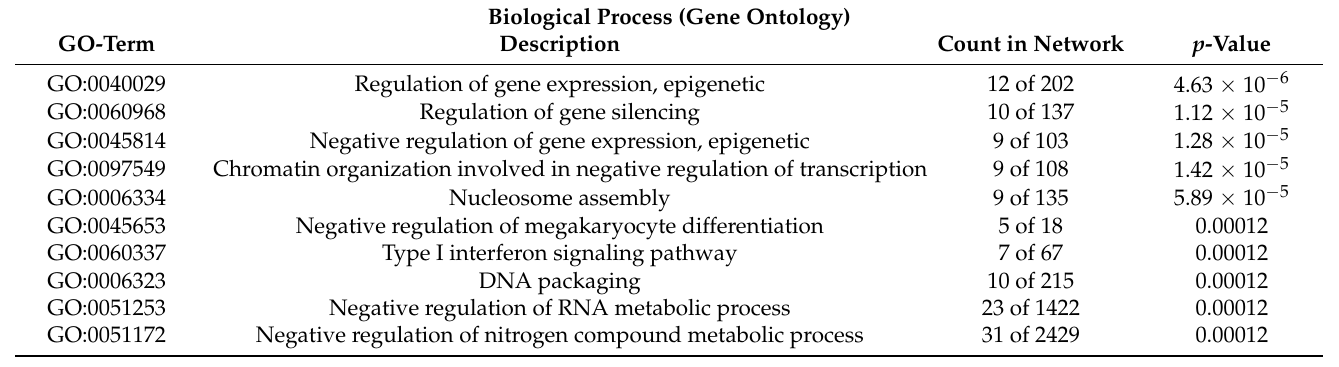
Table 6. Top 10 results of GO analysis in biological processes (TRTLE vs. Control). Biological Process (Gene Ontology)